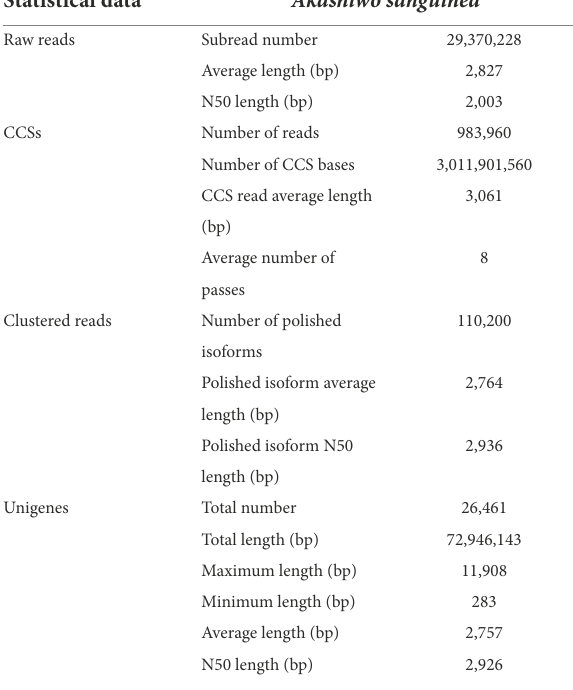
TABLE 2 Summary of the A. sanguinea transcriptome statistics. Statistical